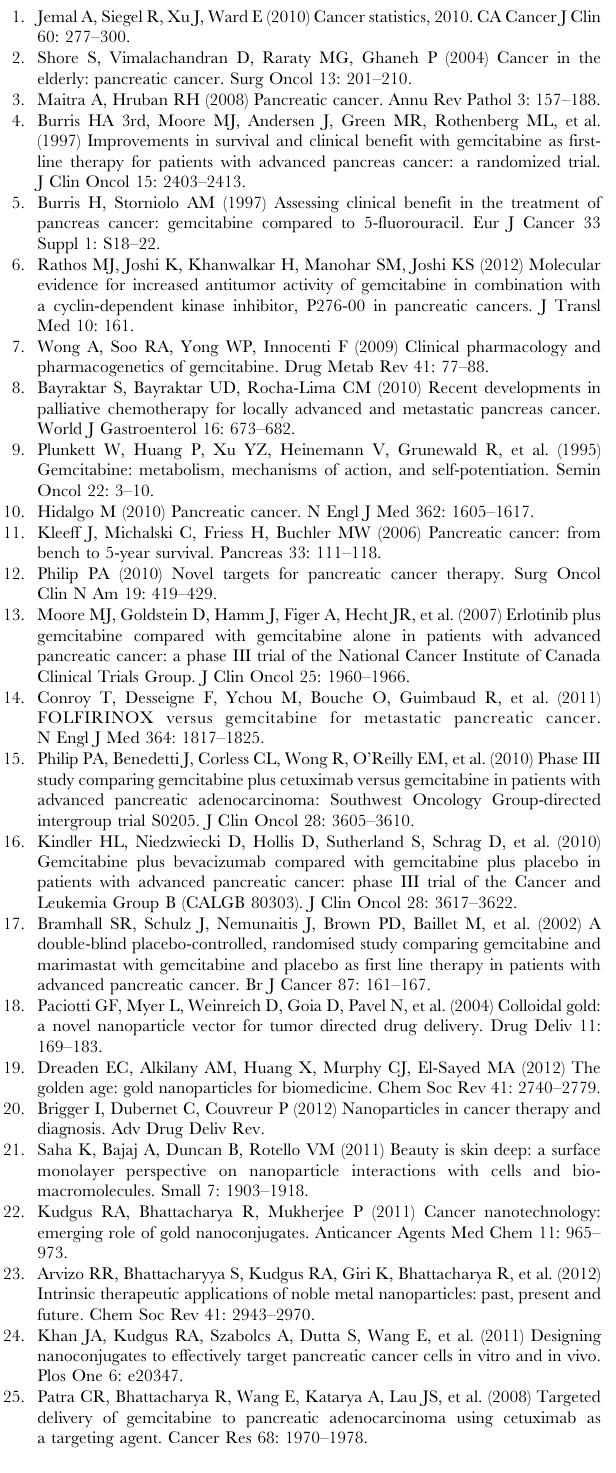
Figure S7 In vivo internalization of AIG44 in tumor tissue depicted with a TEM image. (TIFF) Table S1 Dynamic Light Scattering and Zeta Potential Analysis of all